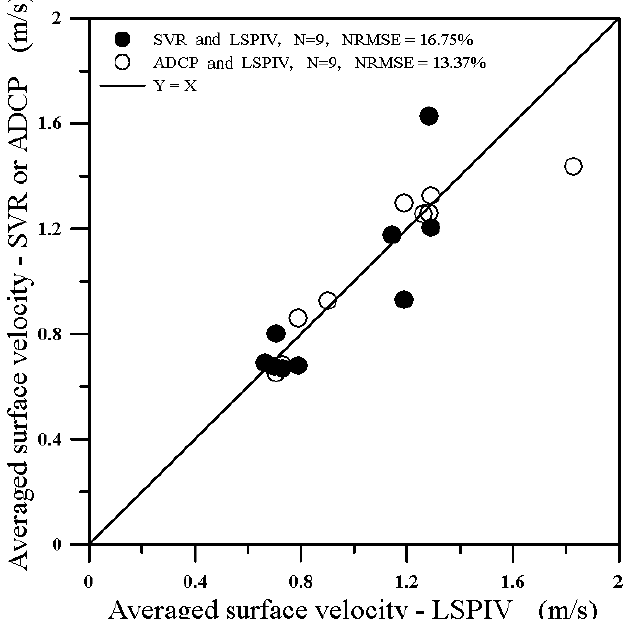
Figure 7. Scatter plot of averaged surface velocities for Large Scale Particle Image Velocimetry (LSPIV) against SVR (solid circles) and ADCP (open circles) measurements.